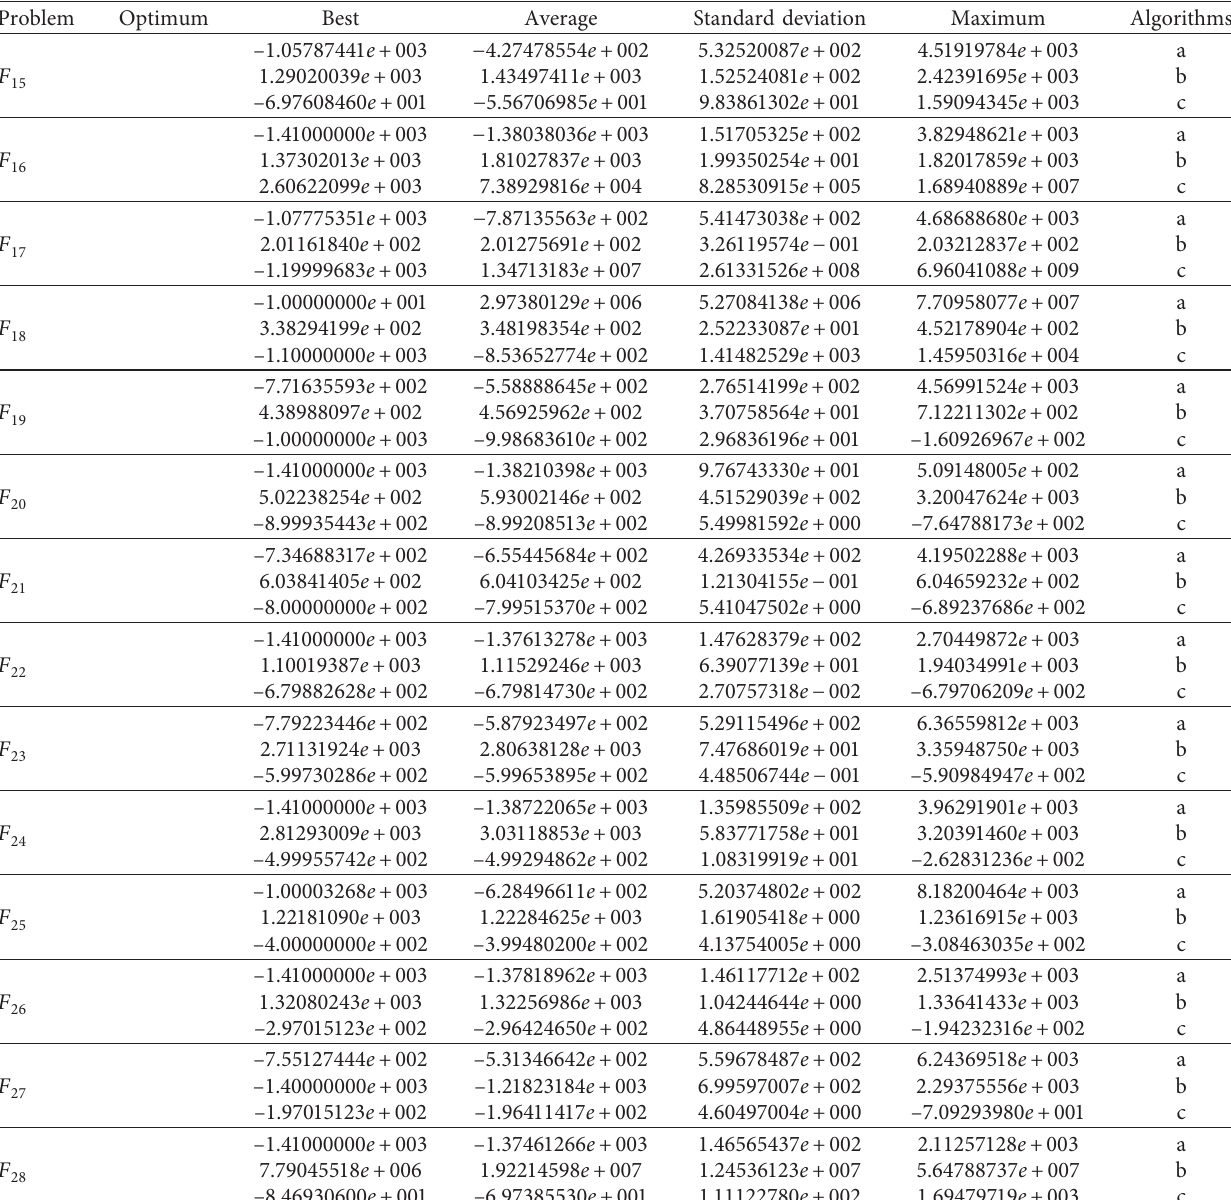
Table 3: The experimental results of (a) MSIA, (b) ACO, and (c) FA by solving the CEC ′ 13 benchmark functions in 10 dimensions